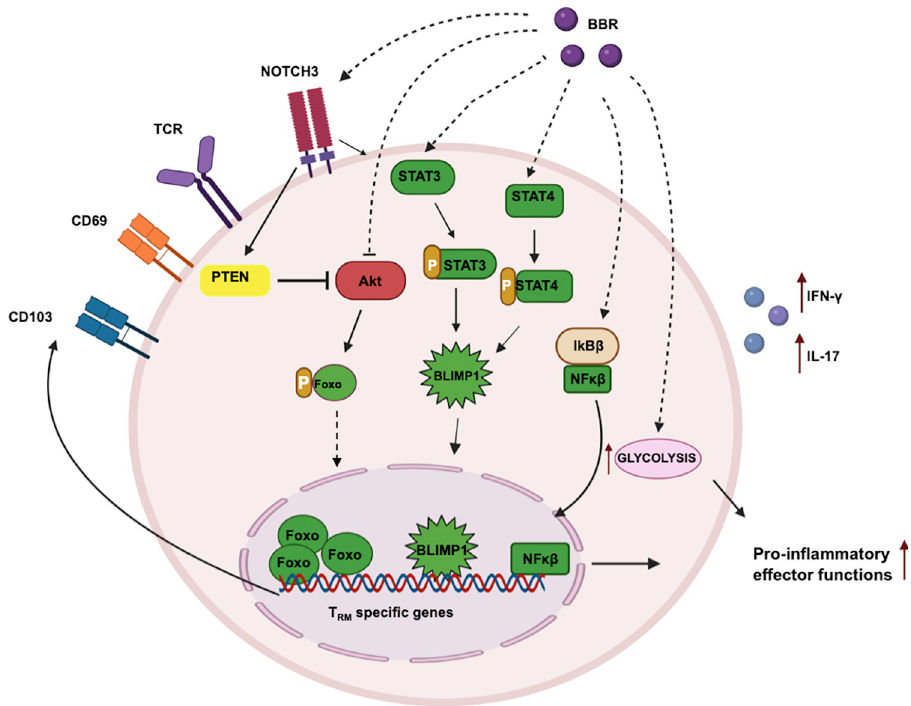
Fig 6. BBR instigates host-protective immune responses against M.tb by directing key immunological signaling pathways. In response to M . tb infection, BBR establishes long-lived, host protective resident memory T cells (TRM) at the site of infection. BBR enhances the effector functions of T lymphocytes by enhancing CD69 expression, directing metabolic flux towards glycolysis, activation of key host protective signaling pathways, and pro-inflammatory immune responses. BBR enriches pathways essential for the establishment and maintenance of memory T cells. BBR upregulates NOTCH3 which directs PTEN to simultaneously inhibit AKT and activate STAT signaling. AKT inhibition further decreases FOXO1 phosphorylation thereby enhancing its nuclear retention. BBR-mediated enhancement of activated STAT4 and STAT3-mediated BLIMP1 signaling axis further results in heightened expression of TRM-specific genes for long-term protection against M.tb